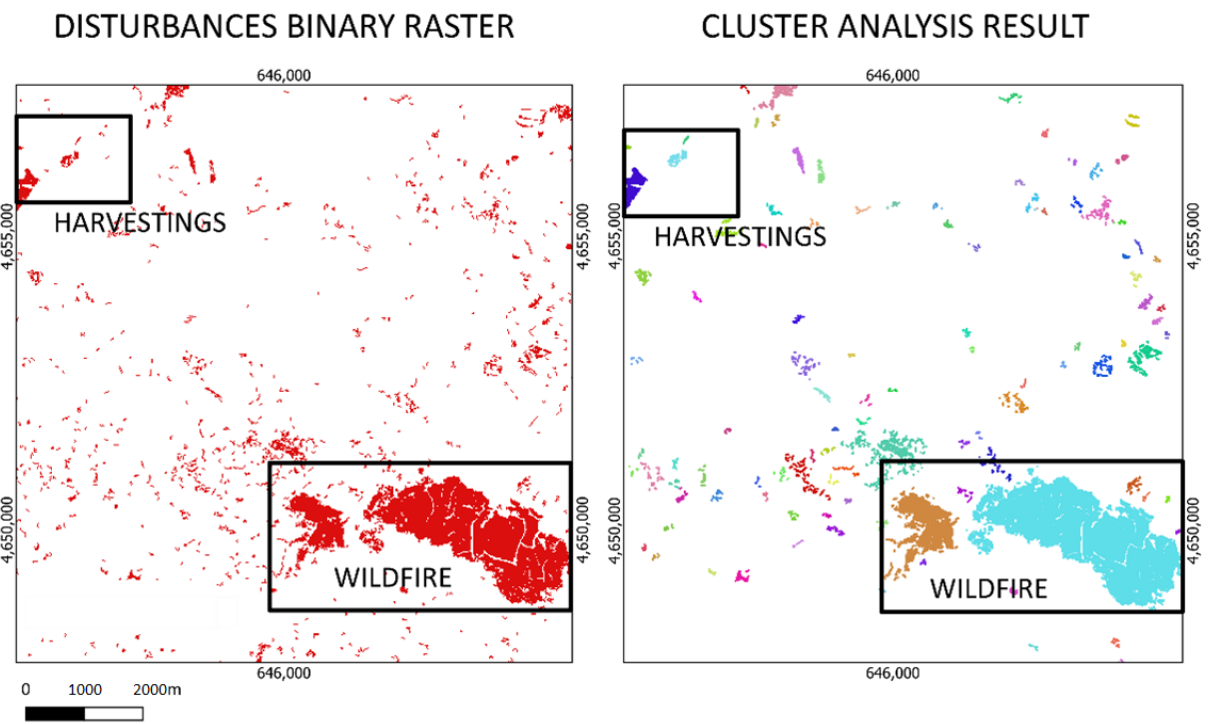
Figure 5. Examples of the cluster analysis results. On the left: disturbances binary raster in red disturbance pixels. On the right: the result of the cluster analysis; all the pixels that belong to a cluster are shown in the same color. Examples of wildfires and harvesting disturbances and clusters are highlighted.